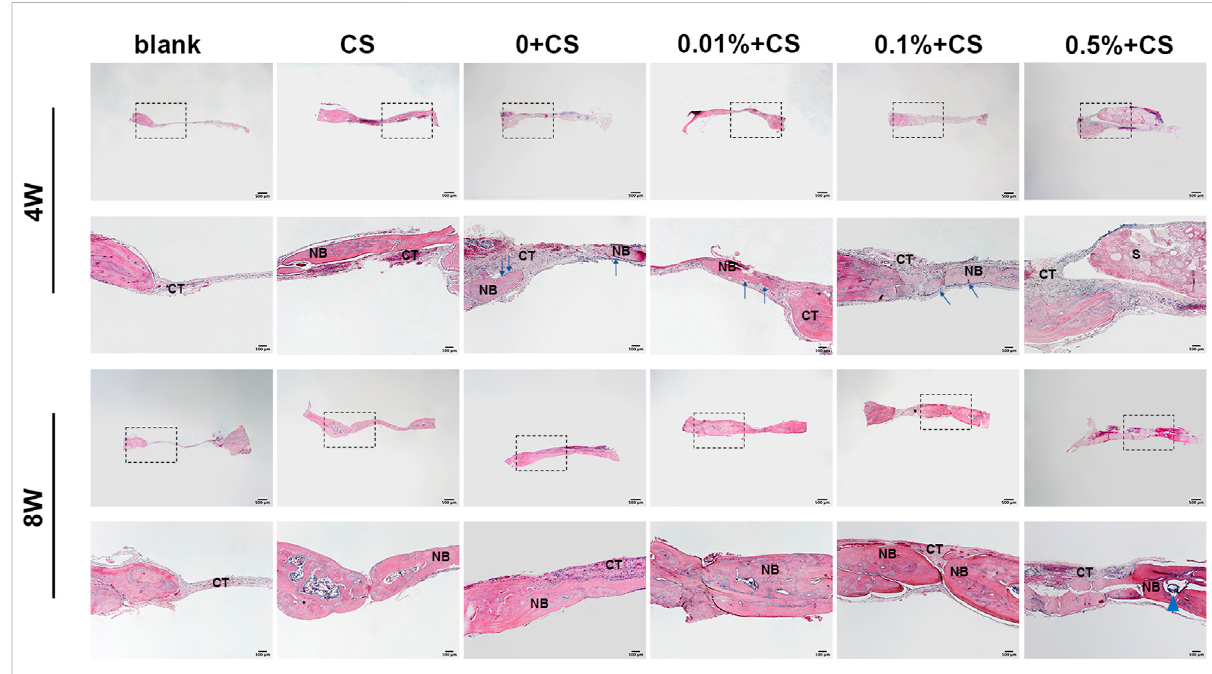
FIGURE 6 Photomicrographsofhematoxylinandeosinretrievedat4wand8wpostoperatively.(S:scaffold,CT,connectivetissue;NB,newbone;CS,cell sheet. The blue arrows indicate osteoblasts, Blue triangular arrows indicate the irregular particle